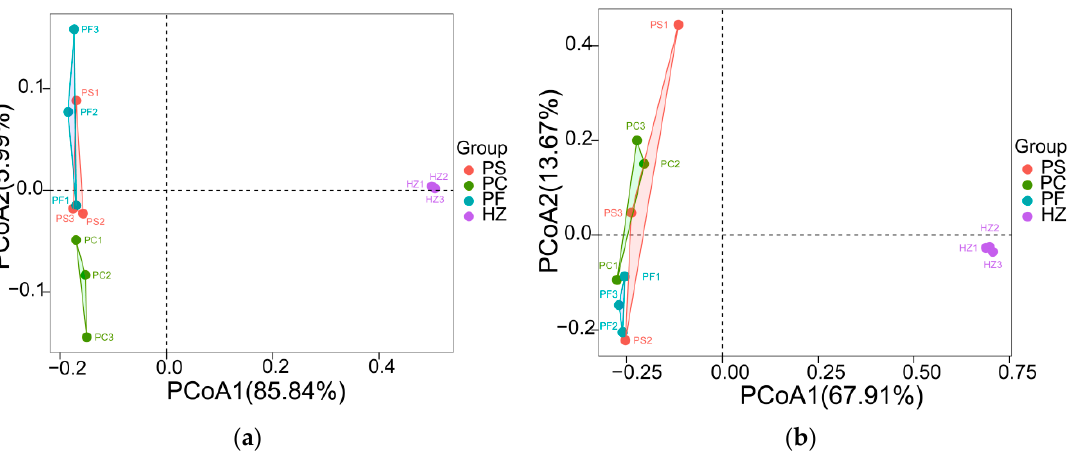
Figure 5. Comparison of bacterial ( a ) and archaeal ( b ) communities retrieved using different methods. The PCoA plot is based on a Bray–Curtis distance matrix of the 16S rRNA gene amplicon libraries.